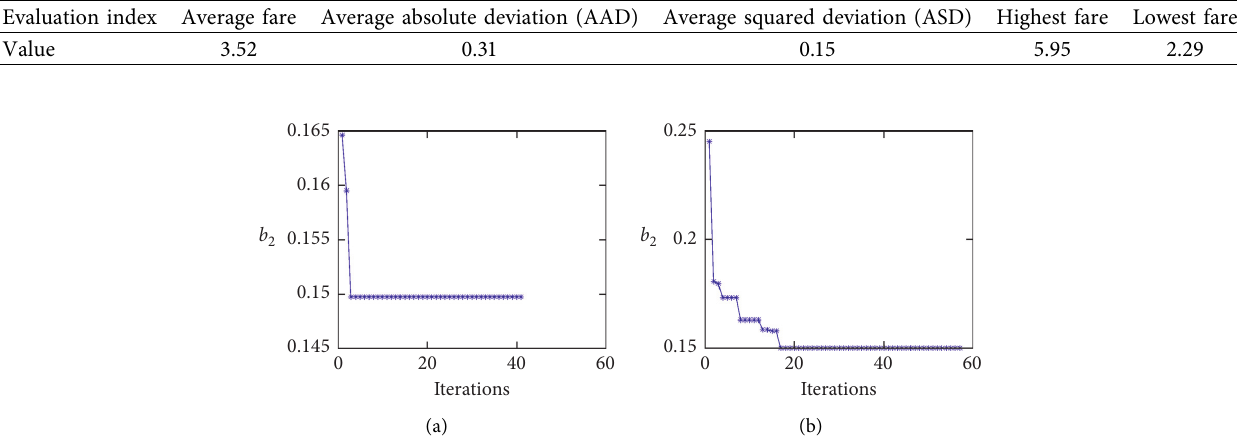
Figure 4: Convergences of the initial schemes under PKM and PF. (a) The value of b